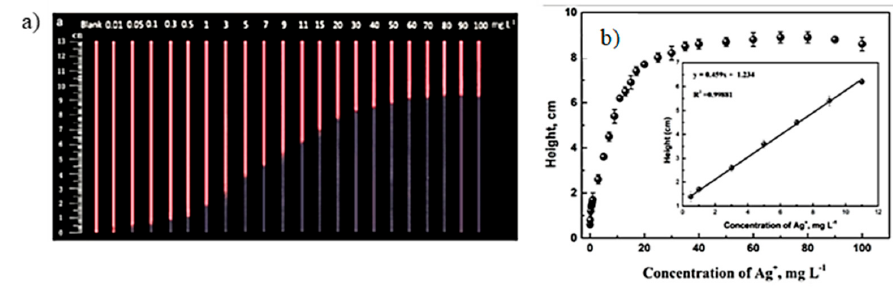
Figure 7. ( a ) Quenching of the fluorescence band in the presence of different concentrations of Ag + in mg/L under UV light at 365 nm. ( b ) Corresponding calibration curve obtained in the presence of various concentrations of Ag + . (Adapted with permission from American Chemical Society) [45].